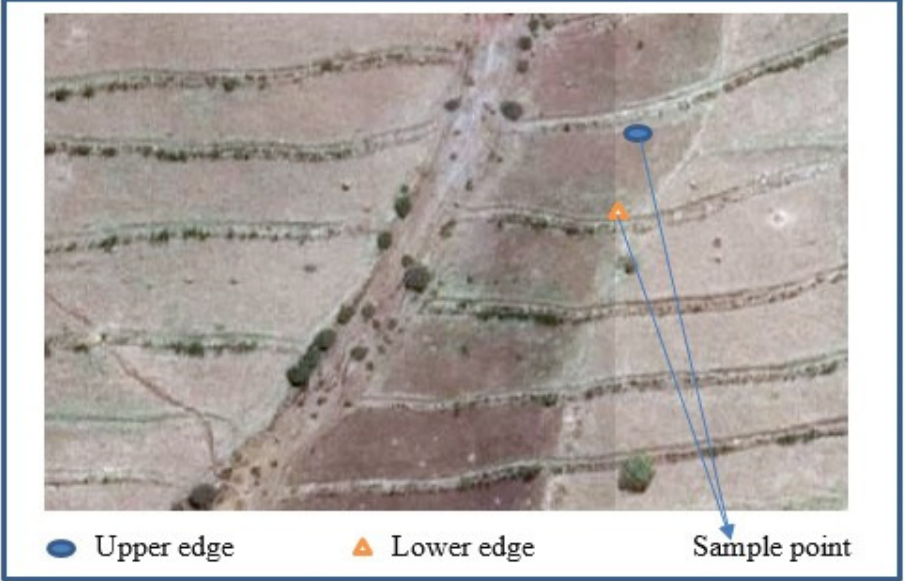
Figure 3. Sampling points from plots at Debre Mewi with SWC bunds. While the upper point represents the position below the bund, the lower point represents the above.